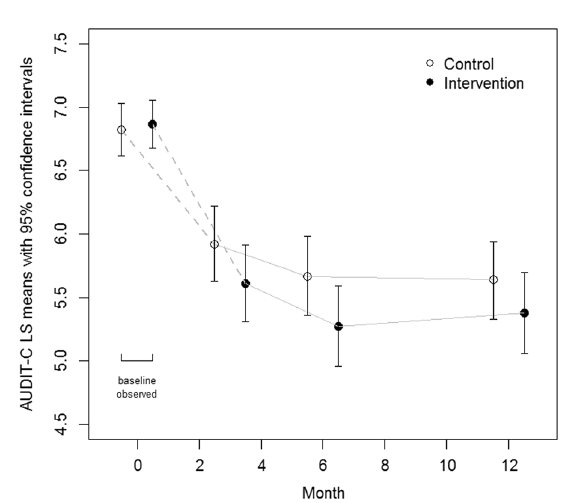
Fig. 2 Least squares mean AUDIT-C scores at baseline and 3, 6 and 12-month follow-up points from a mixed model for repeated measures